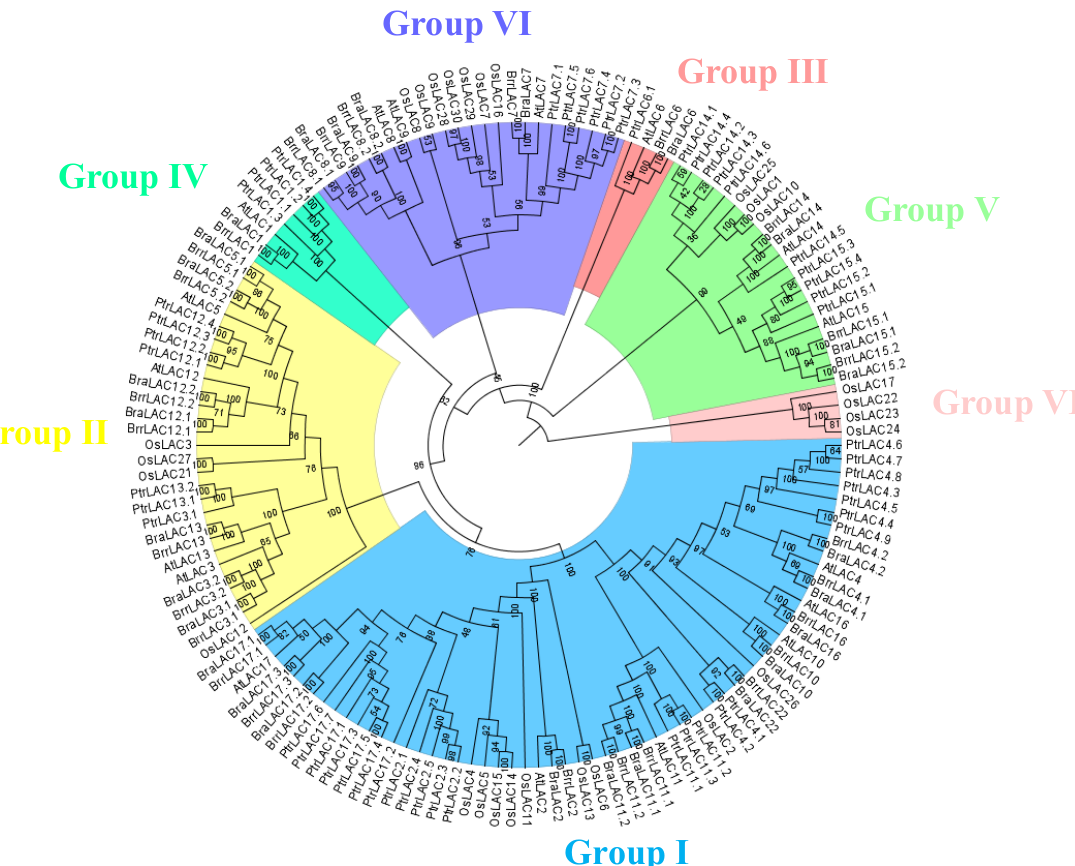
Figure 2. Phylogenetic analysis of laccase proteins from turnip and Chinese cabbage. Phylogenetic tree was constructed using laccase proteins from turnip (27), Chinese cabbage (27), Arabidopsis thaliana (17), Oryza sativa (27), and Populus trichocarpa (52). Phylogenetic tree was constructed using MEGA 7.0, by the neighbor-joining method, with 1000 bootstrap replicates.